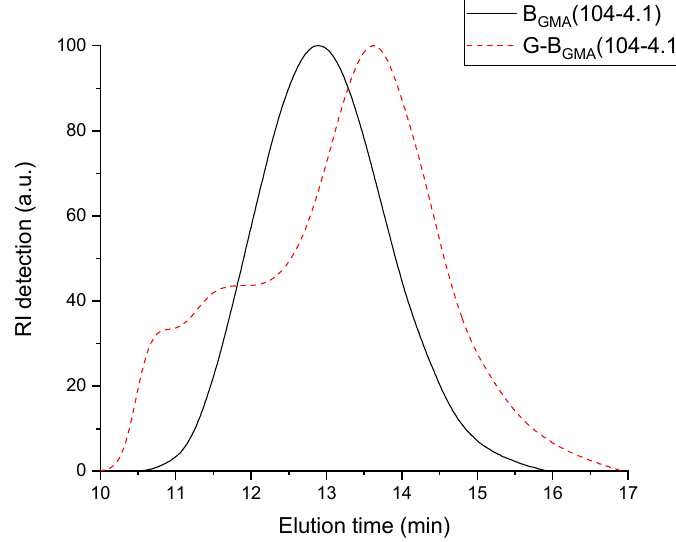
Figure 2. RI elugram of B GMA (104-4.1) before and after graft copolymerization.